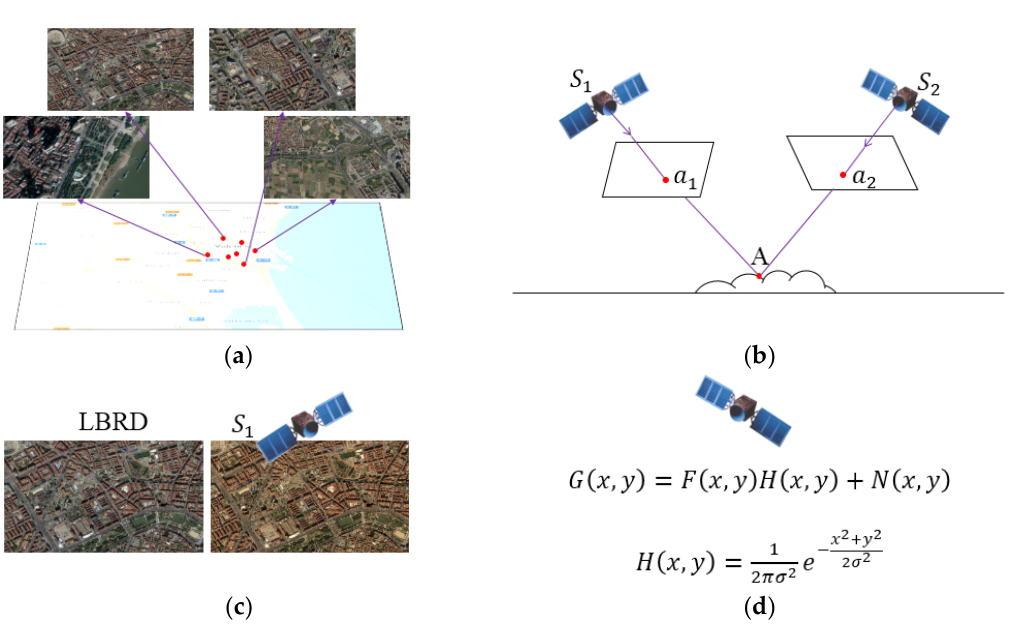
Figure 2. Sketch of the long-term background referencing library (LBRL) for long-term background redundancy (LBR) elimination. ( a ) Corrected historical images registered at corresponding locations in the scale of a smart city, forming the foundation library of the LBRL; ( b ) projection transformation; ( c ) radiometric adjustment; ( d ) quality adjustment.